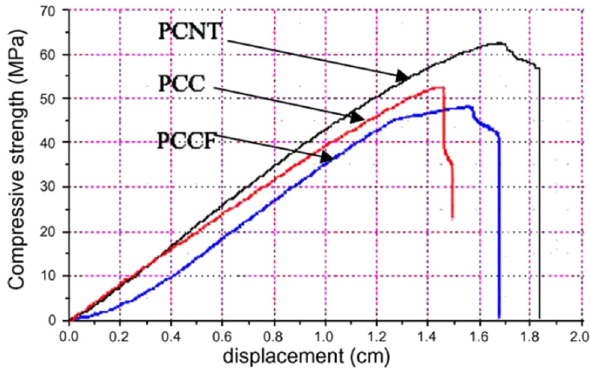
Figure 20: Typical load - displacement curves of cement - CNT com - posites. PCC: control Portland cement composite; PCCF: Portland cement - untreated carbon fi bers composite; PCCT: Portland cement